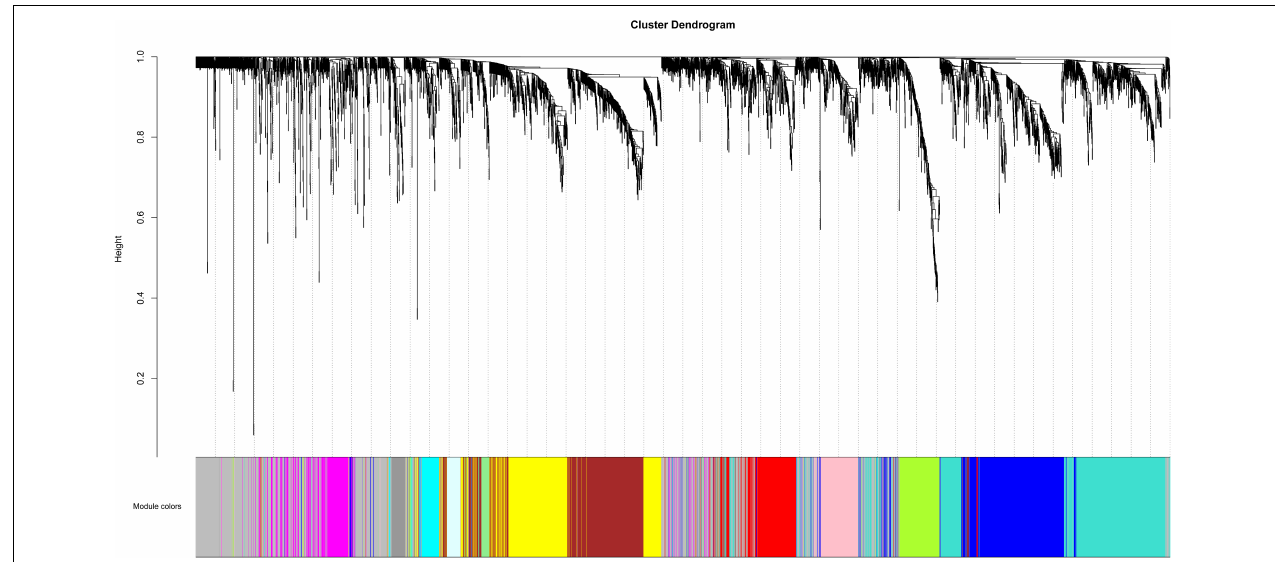
FIGURE 3 | Clustering dendrogram of genes. The color bands provide a simple visual comparison of module assignments (branch cuttings) based on the dynamic tree cutting method.